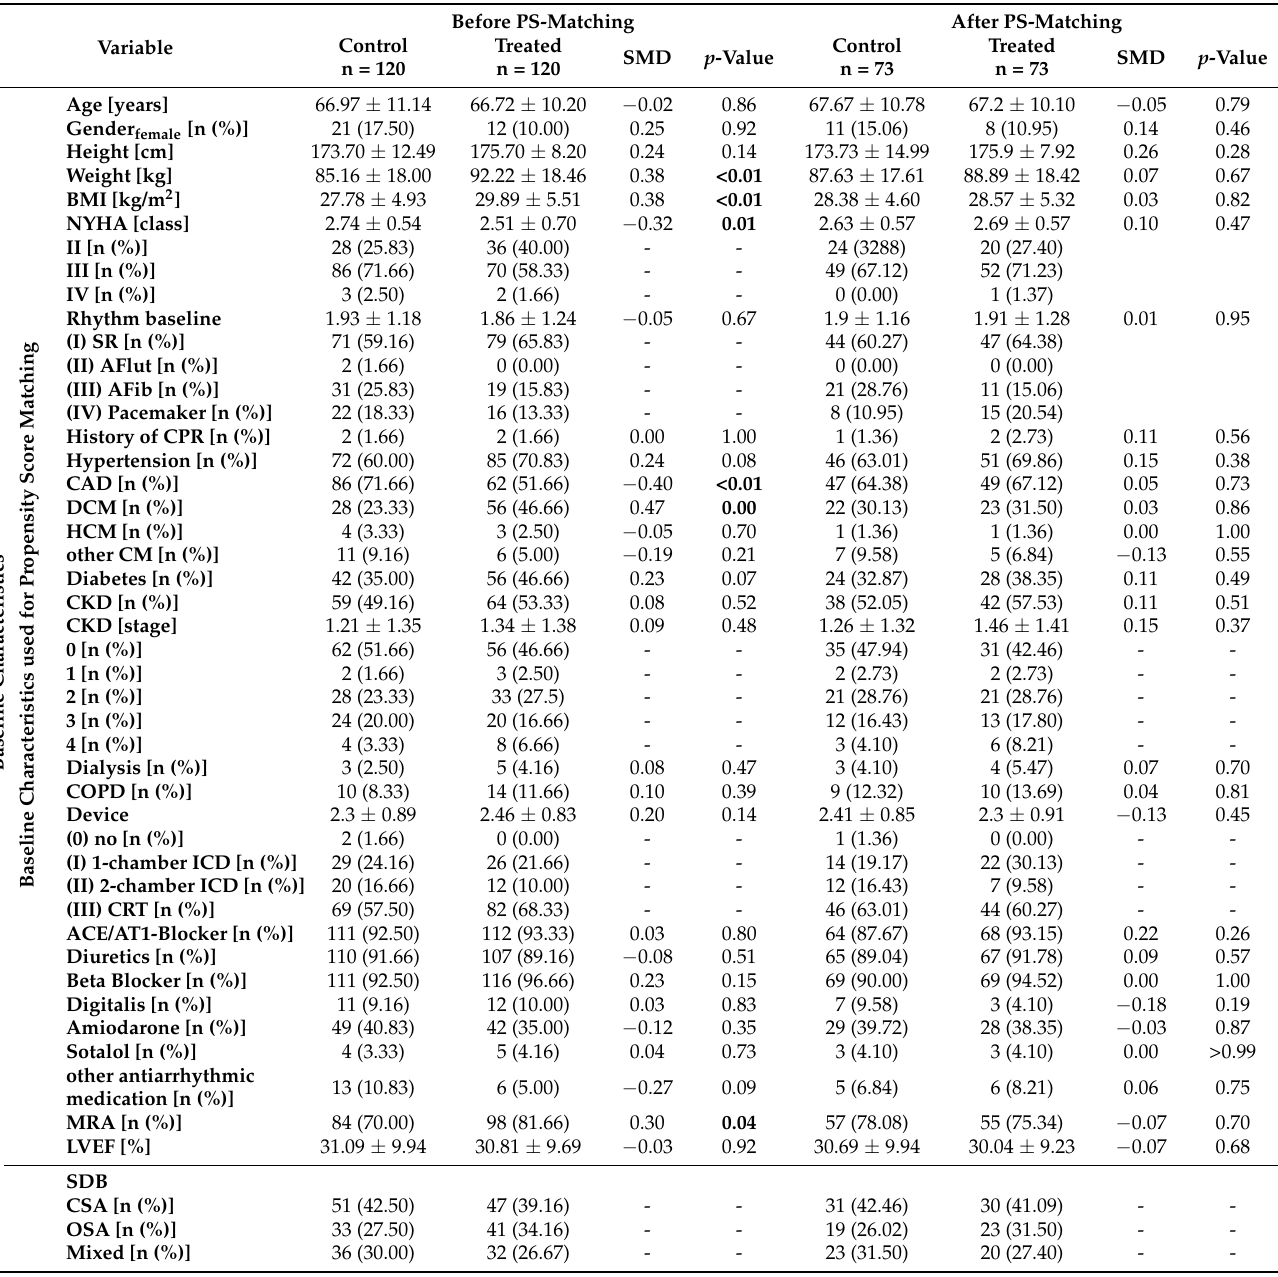
Table 1. Baseline Characteristics and Propensity Score